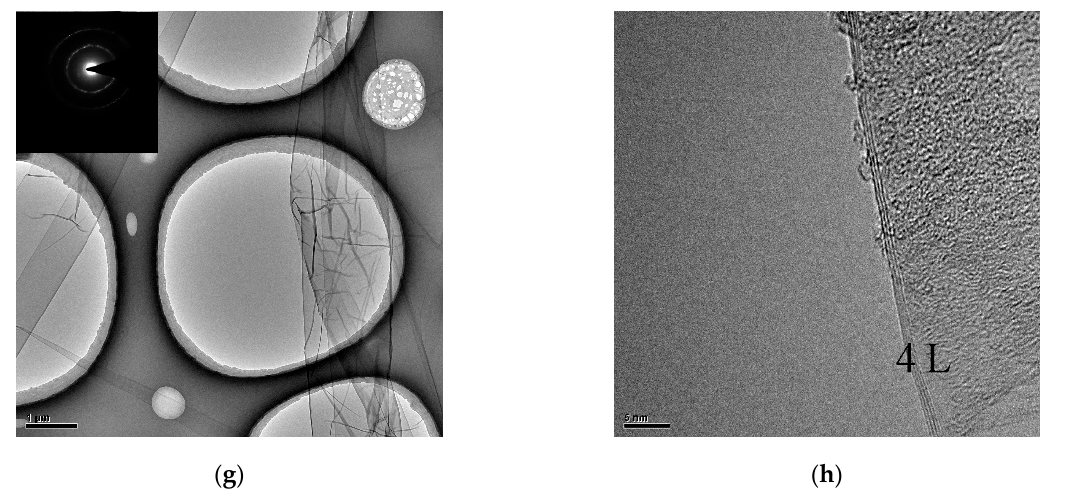
Figure 2. Representative TEM image ( a ) and high resolution TEM image ( b ) of Sample No.1, TEM image ( c ) and high resolution TEM image ( d ) of Sample No. 2, TEM image ( e ) and high resolution TEM image ( f ) of Sample No. 3, TEM image ( g ) and high resolution TEM image ( h ) of Sample No. 4.